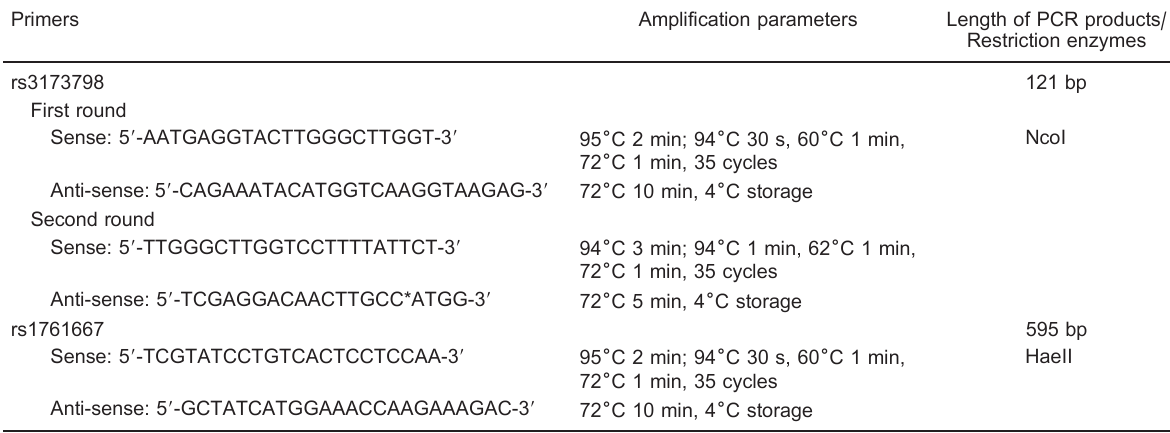
Table 1. Primers, amplification parameters and restriction enzymes of polymerase chain reaction.